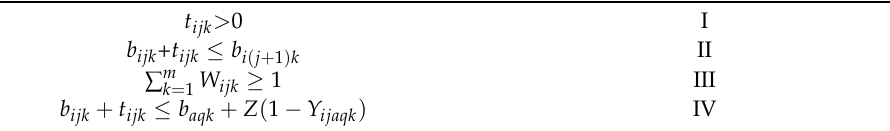
Table 2. The mathematical expression of constraints.